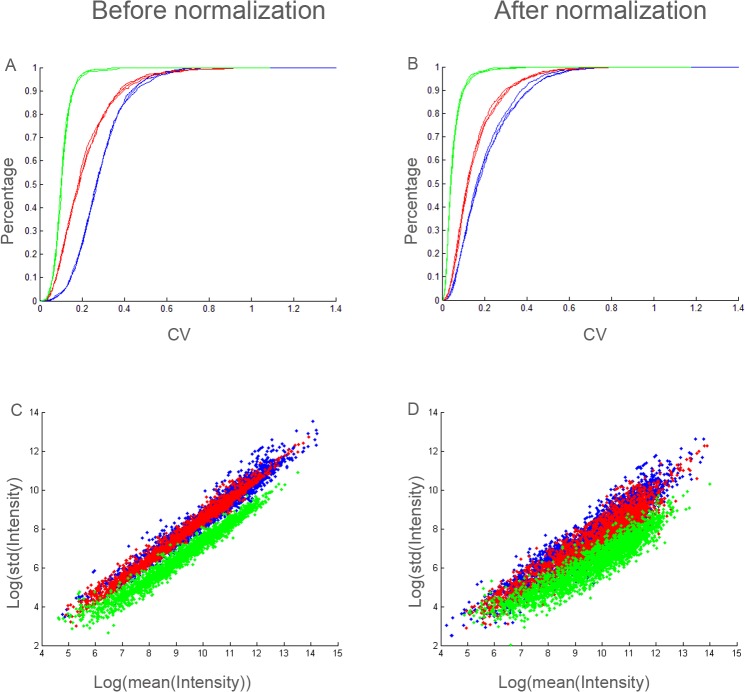
Comparison of coefficient of variations in the three different set-up: labeling (green), technical (red) and total (blue) variation set-up.Upper panels (A+B): Plot of coefficient of variation versus the percentage of peptides. The peptides included in these graphs are those present in the intersection of the triplicate runs. The curves after normalization (B) are shifted more to the left, indicating a reduction of the variability. Lower panels (C+D): Comparison of log2(standard deviation) of these ‘intersection’ peptides as a function of the log2 (mean reporter intensity). The scatterplot demonstrates that removing the systematic effects that drive the CV by normalization, results in more variability between the peptides.